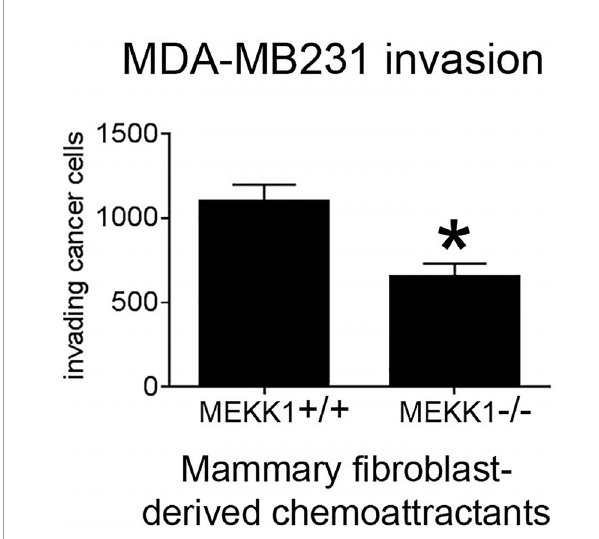
FIGURE 1 | MEKK1 expression is necessary for mammary fi broblasts to promote breast tumor cell invasion. The graph depicts results from BioCoat Matrigel assays of MDA-MB 231 cell invasiveness induced by media that had been conditioned by either MEKK1+/+ or MEKK1 − / − mammary fi broblasts for 72 h. The data represented in graph are derived from at least three independent experiments. *p < 0.05 by paired